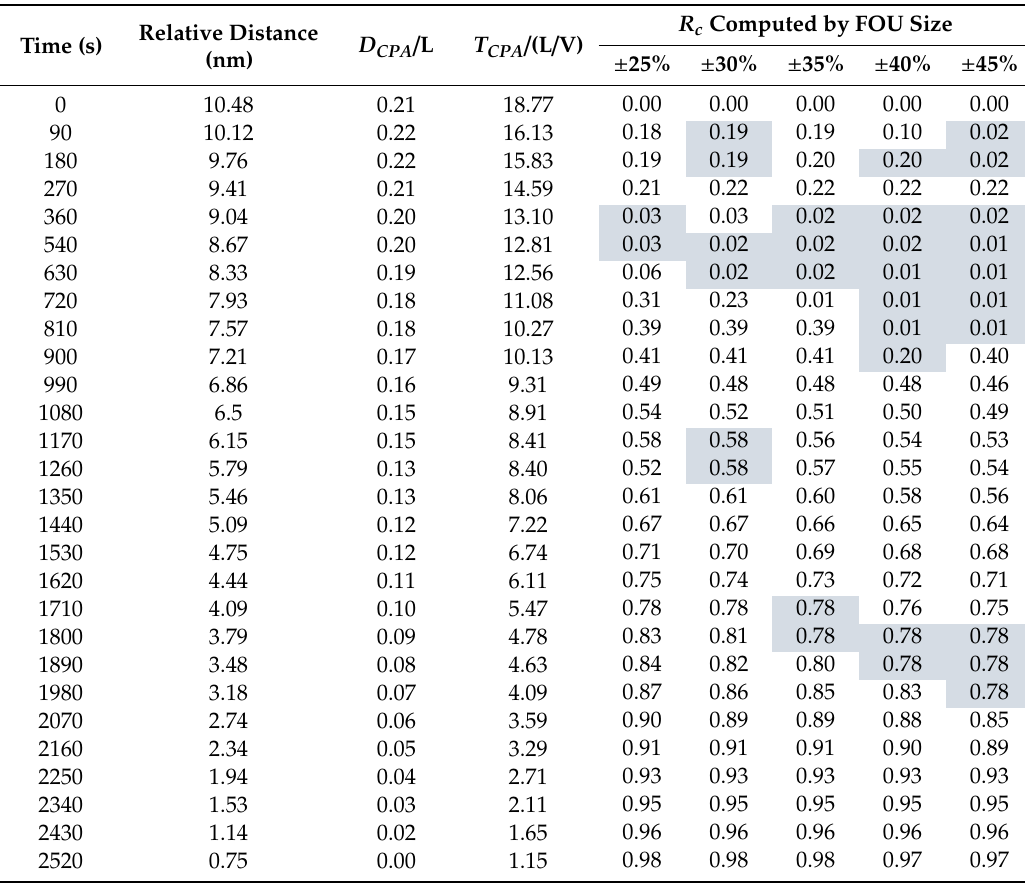
Figure 16. Non-linear R c by time and relative distance. Table 5. Non-linear R c computed by di ff erent FOU size: background color is identical R c .